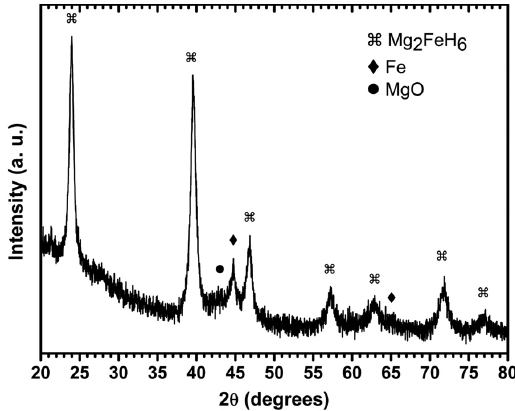
Figure 1. X-ray powder diffraction pattern of 2Mg-Fe reactive milled under 30 bar of H for 48 hours. 2